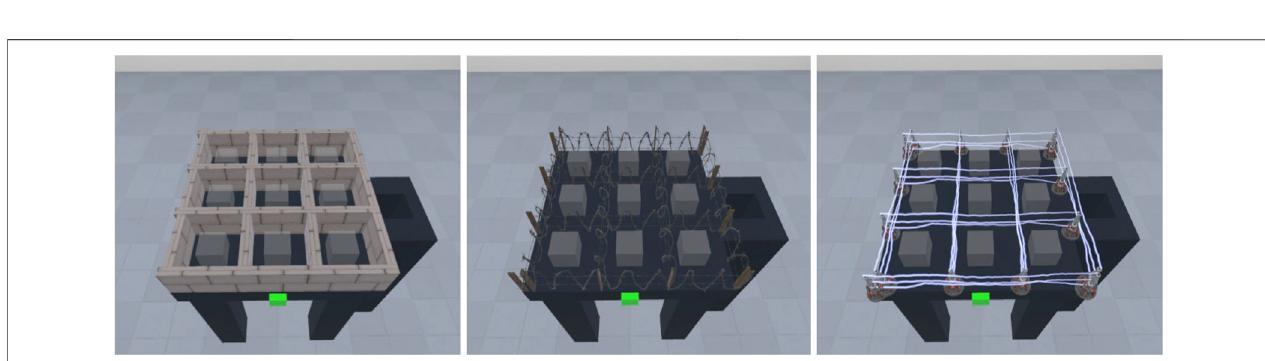
FIGURE 4 | Virtual obstacles that appear on the table during the tasks: from left to right (A) Brick Wall obstacle, (B) Barbed Wire obstacle, (C) Electric Current obstacle.